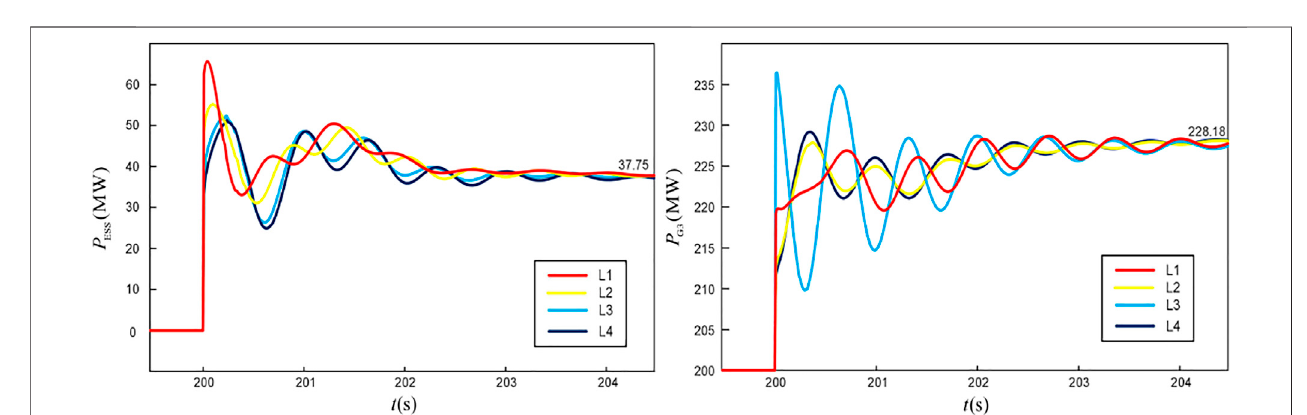
FIGURE 6 | Output of the ESS and the synchronous unit under Δ P L1 – Δ P L4 .